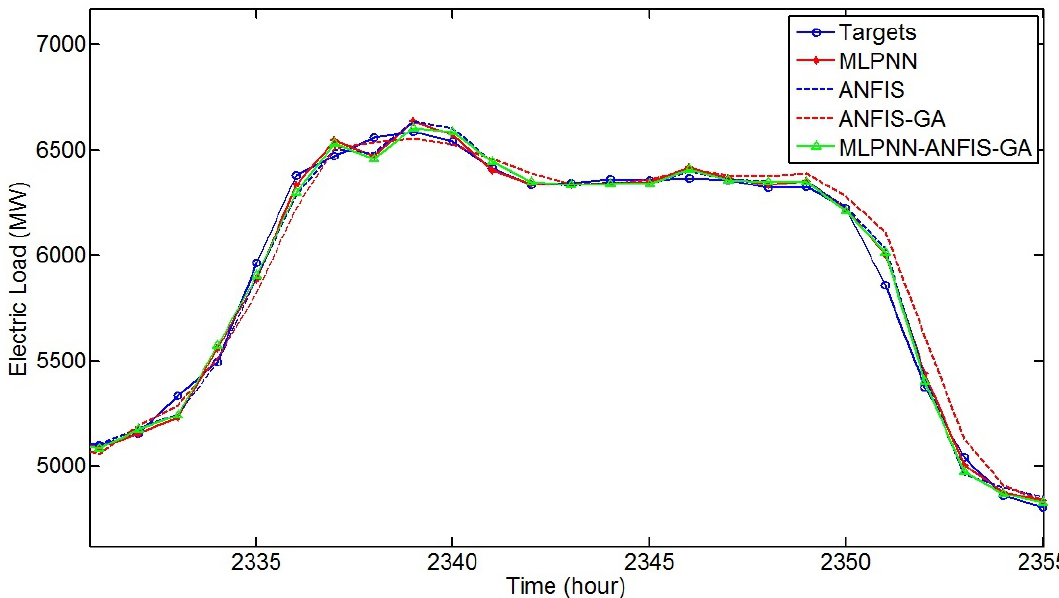
Figure 11. Forecasting results for a one-day